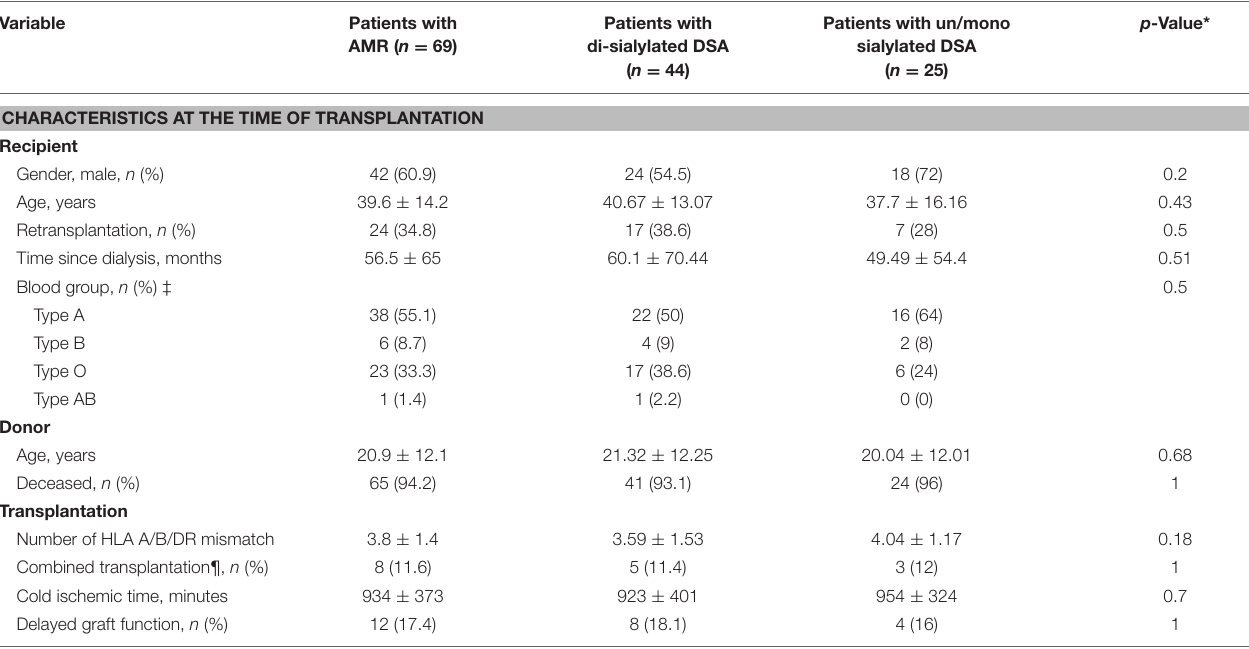
TABLE 1 | Patient characteristics at baseline.